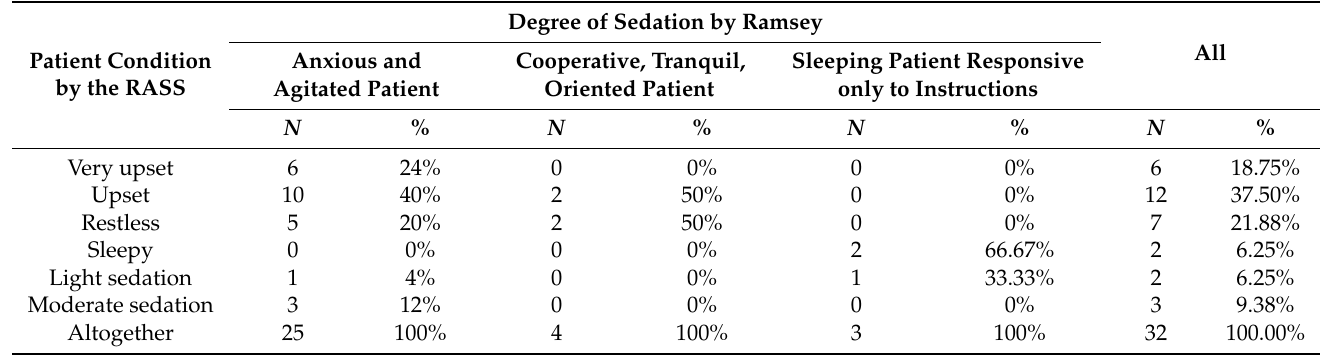
Table 5. RASS patient status in the Ramsey Sedation Grade groups.